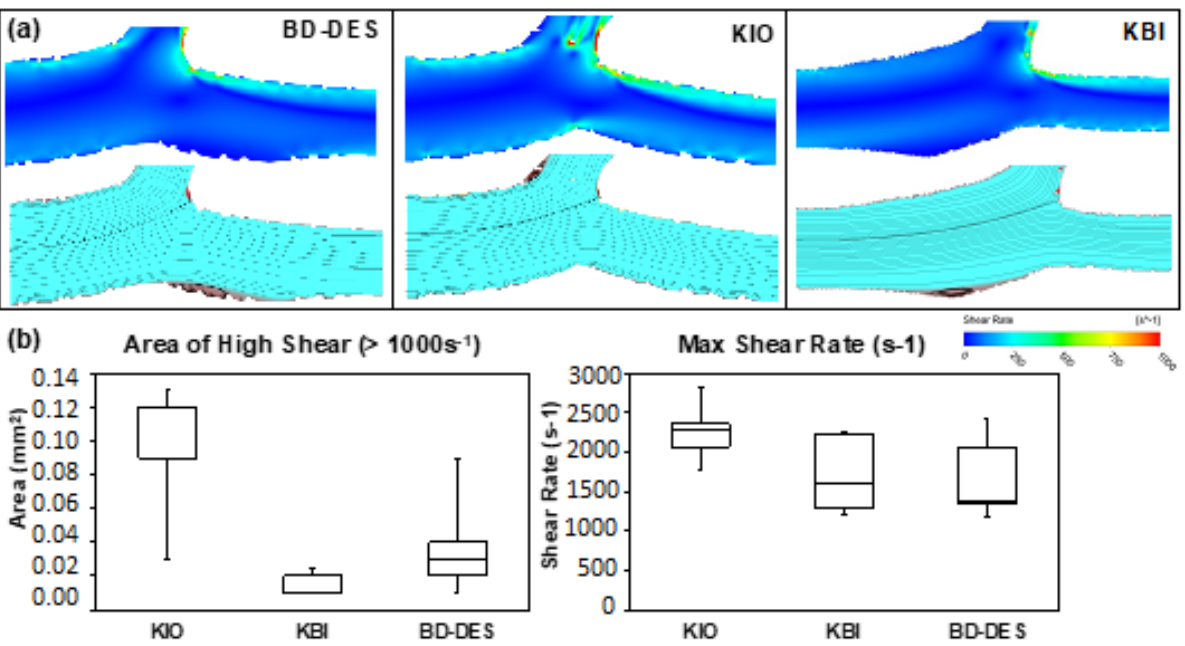
Figure 4. ( a ) Representative CFD images and ( b ) area of high shear (>1000 s − 1 ) and maximum shear rate quantification of the three groups ( n = 5).